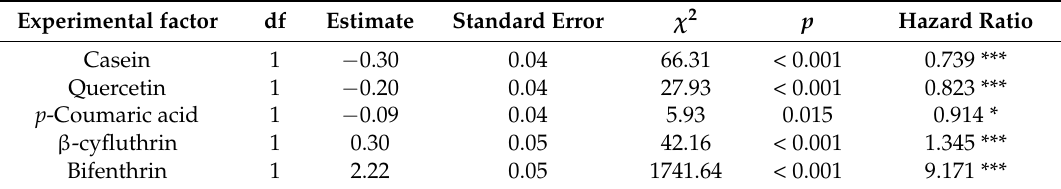
Table 2. Cox proportional hazards model analysis of effects of diet amendments on adult honey bee longevity.